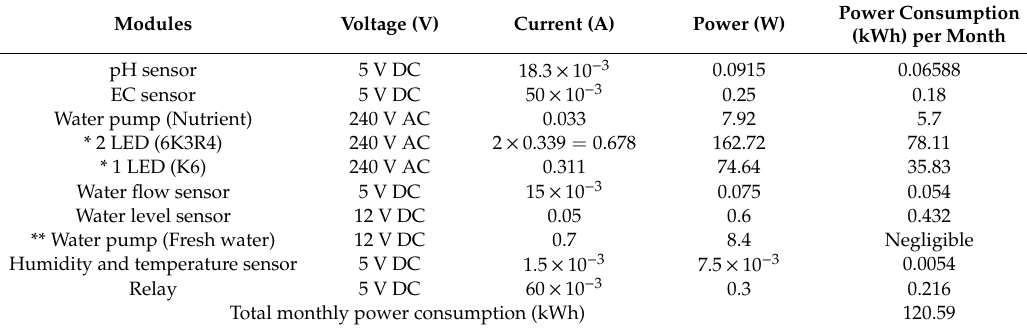
Table 1. Power consumption of the individual system